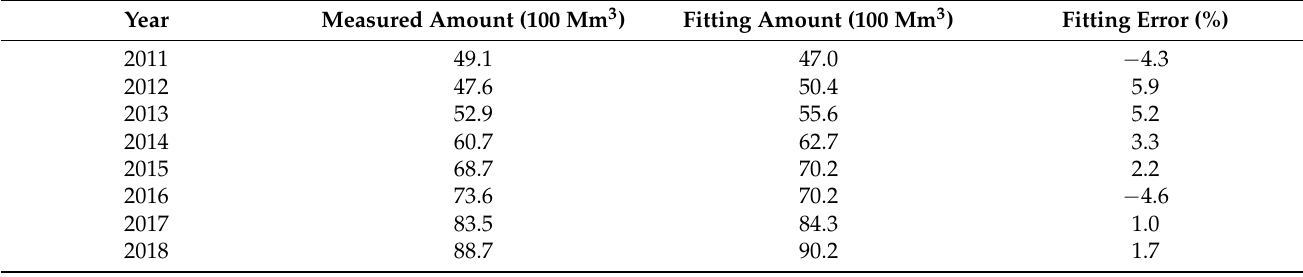
Table 9. Fitting results of the REM 1